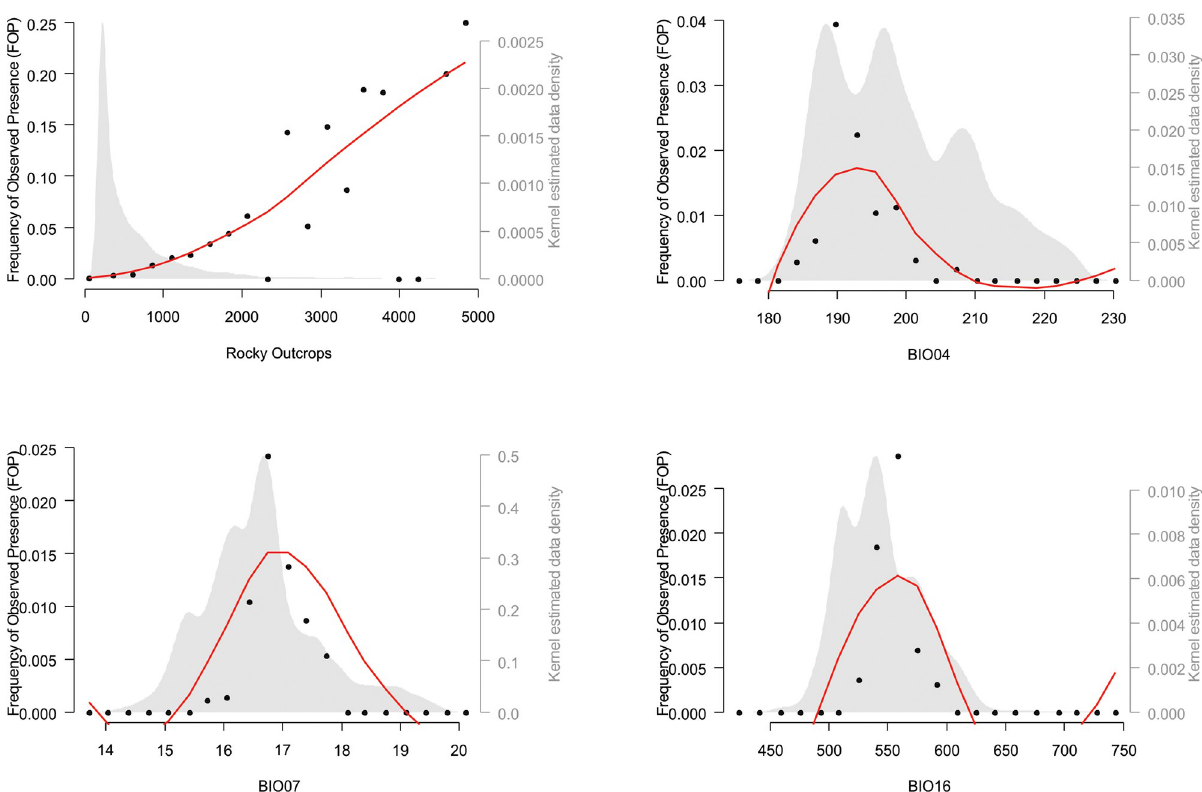
Fig 3. Frequency of observed presence of Lutzomyia longipalpis represented by the black dots and the red line as a local regression smoother across the significant environmental variables retained in the final model: Rocky outcrops, temperature seasonality (BIO04), temperature annual range (BIO07), and precipitation of the wettest quarter